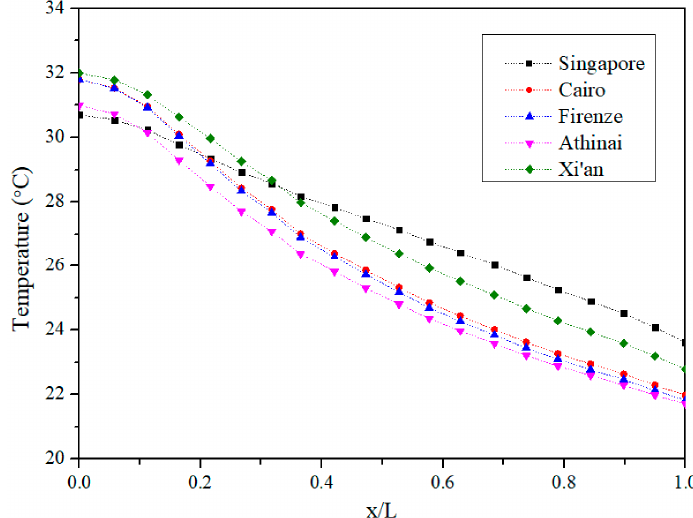
Figure 5. Product air temperature distributions in the pre-cooling IEC.